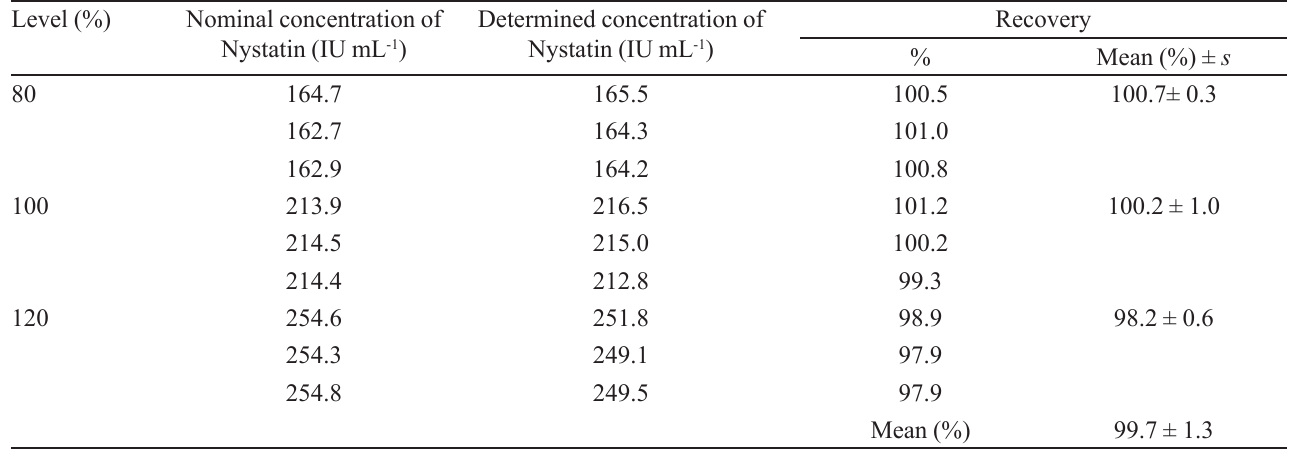
TABLE IV - Percentage of recovery for Nystatin